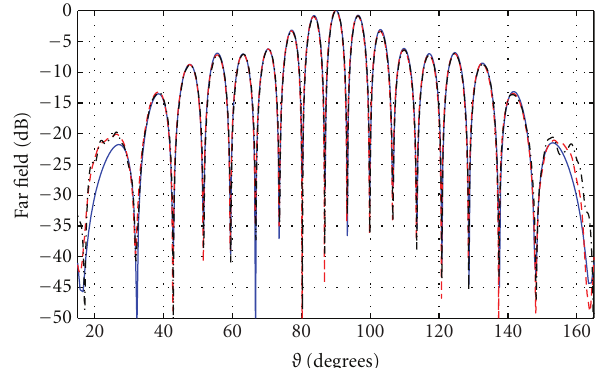
Figure 10: Dual horn, vertical polarization. ϑ cut of the ϑ compo- nent of the far field. Blue solid line: proposed approach. Red dashed line: approach in [7, 8]. Black dash-dot line: standard, probe- compensated NF-FF transformation.